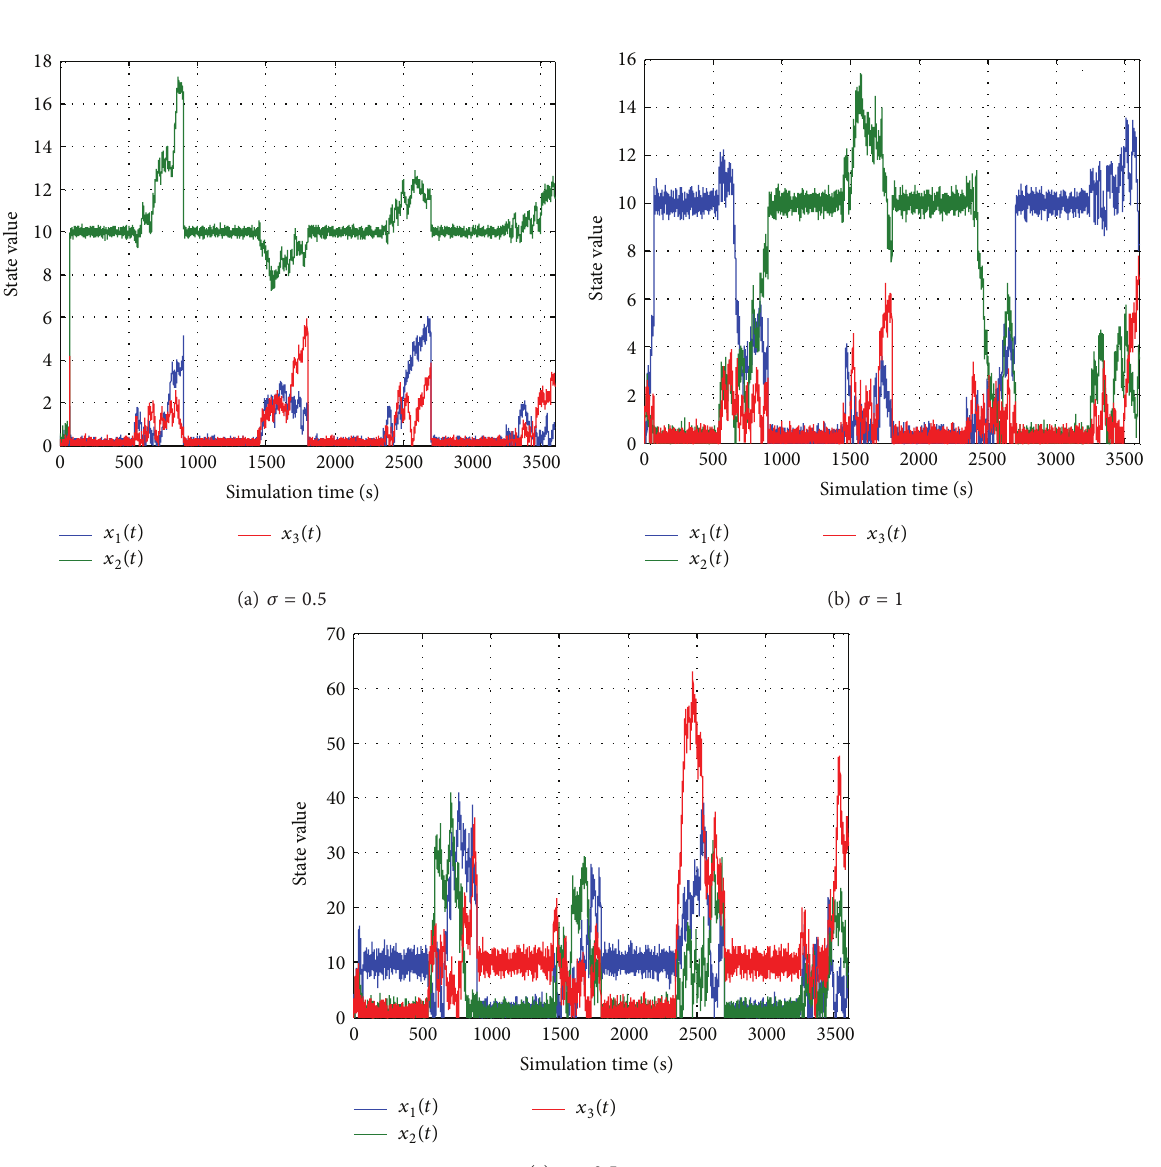
Figure 2: Evaluation of the impact of the random noise variability on the dynamics